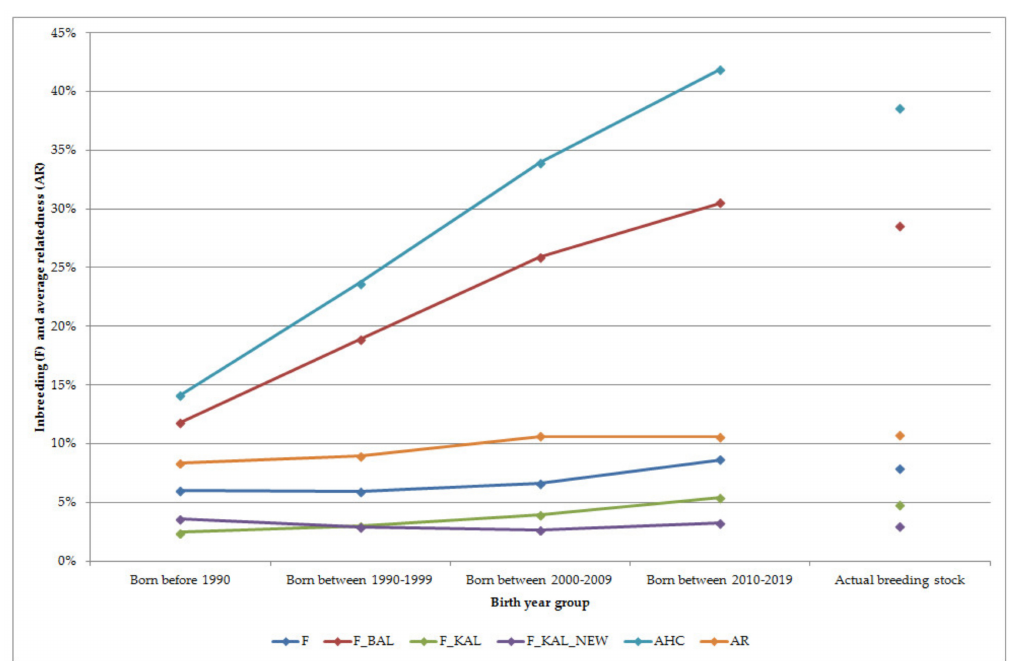
Figure 2. Inbreeding and average relatedness of the di ff erent groups; F—inbreeding coe ffi cient; F _BAL —Ballou’s formula for ancestral inbreeding; F _KAL —identical alleles were inbred in the past; F _KAL_NEW —identical alleles were inbred in recent generations; A HC —ancestral history coe ffi cient; AR—average